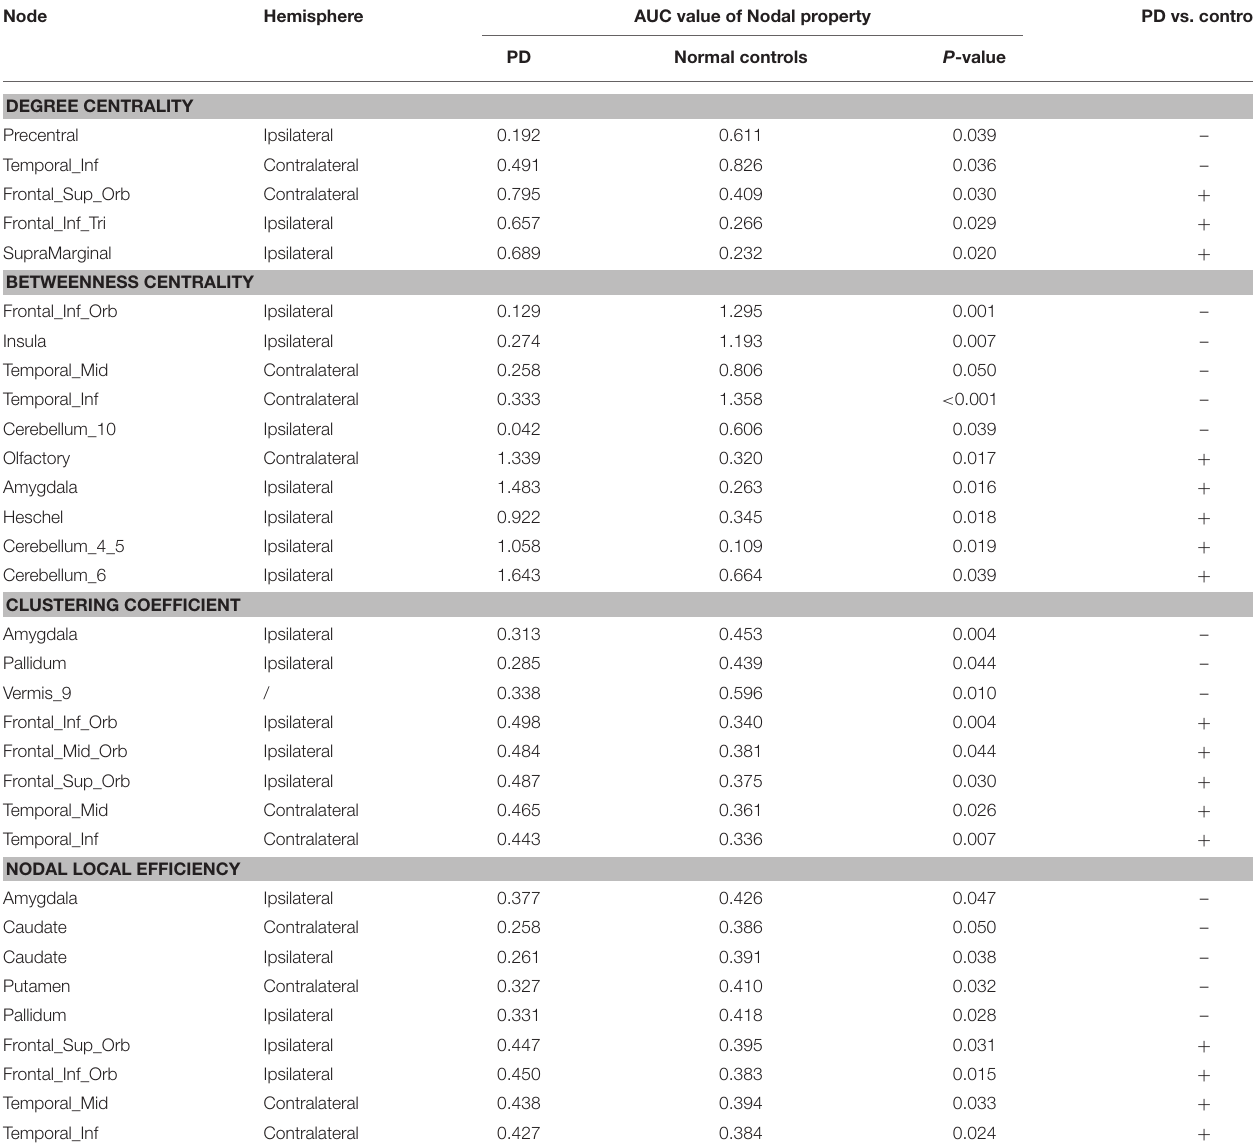
TABLE 3 | Alterations of nodal measures between PD and normal controls. Node Hemisphere AUC value of Nodal property PD vs.